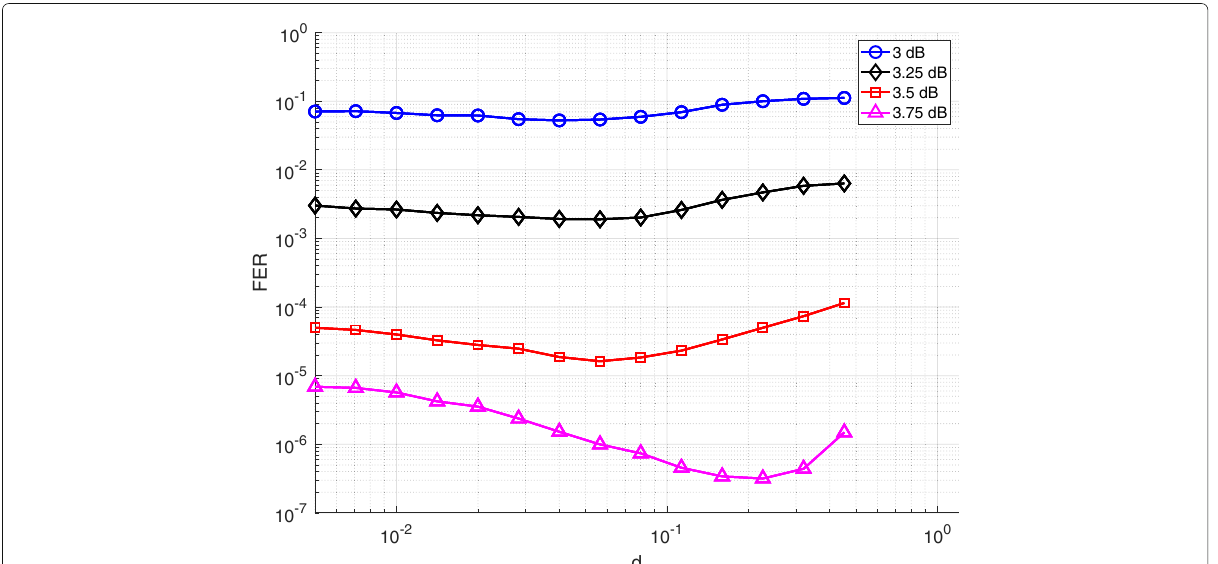
Fig. 4 Quasi-regular density plot. FER performance of an augmented decoder with N = 100 candidates with varying augmentation density d for the n = 4095 and R = 0.82 quasi-regular code